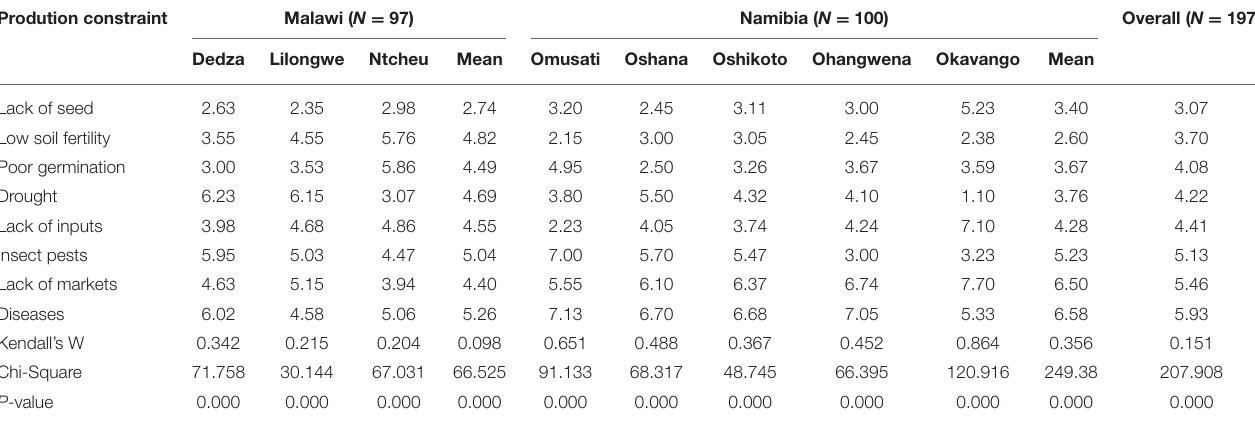
Kendall’s W Chi-Square P